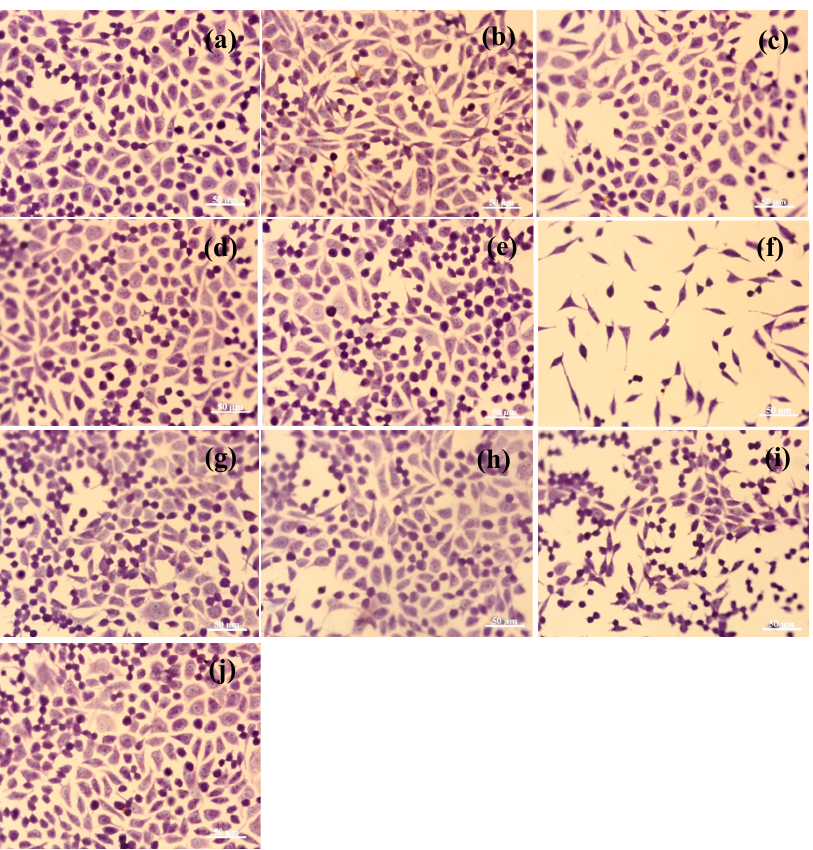
Figure 8. Light microscope images of L929 fibroblast cells treated with electrospun HC10CC nanofibers at concentrations of 0.1, 1, and 5 mg / mL ( a – c ); electrospun KH nanofibers at concentrations of 0.1, 1, and 5 mg / mL ( d – f ); electrospun RCG nanofibers at concentrations of 0.1, 1, and 5 mg / mL ( g – i ); and untreated cells (control— j ) for 72 h (Giemsa staining). Scale bar = 50 μ m.